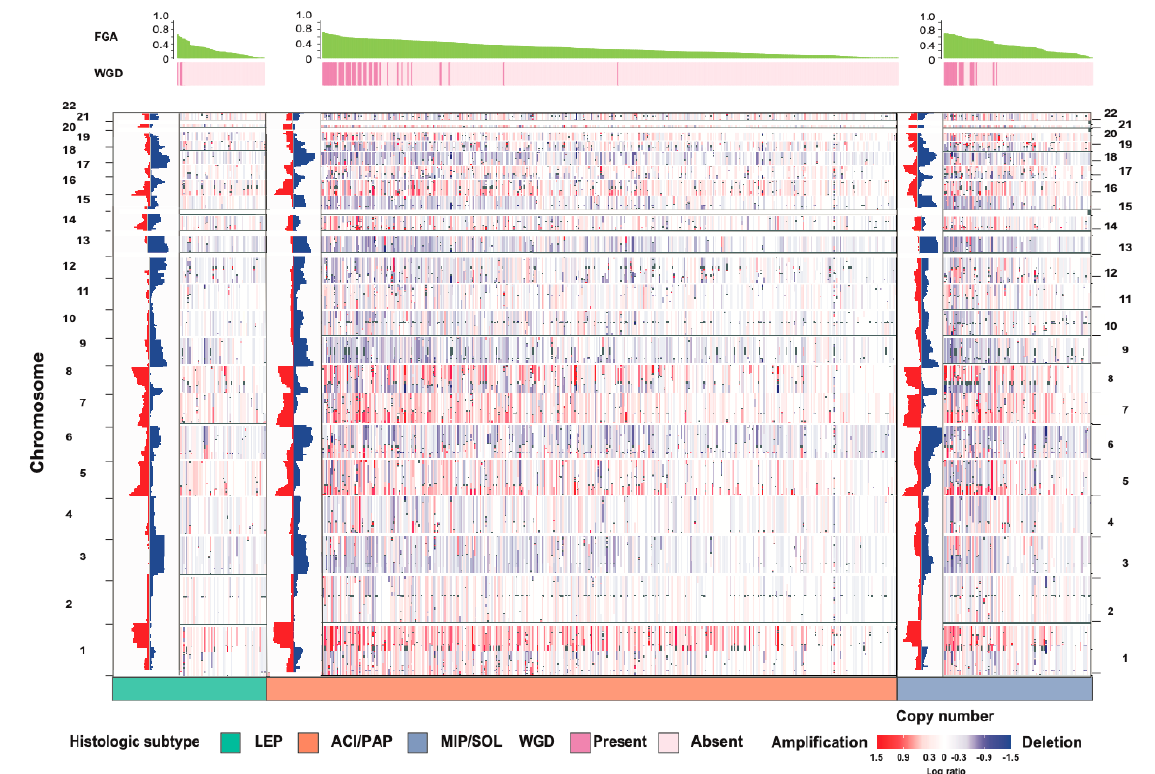
Figure 1. Analysis of copy number alterations by histologic subtype of invasive lung adenocarcinoma. The copy number heat map with amplifications (red) and deletions (blue) by histologic subtype, arranged by decreasing FGA. ACI, acinar; FGA, fraction of genome altered; LEP, lepidic; MIP, micropapillary; PAP, papillary; SOL, solid; WGD, whole-genome doubling. (From Journal of Thoracic Oncology , Caso, R.; Sanchez-Vega, F.; Tan, K.S.; Mastrogiacomo, B.; Zhou, J.; Jones, G.D.; Nguyen, B.; Schultz, N.; Connolly, J.G.; Brandt, W.S., “The underlying tumor genomics of predominant histologic subtypes in lung adenocarcinoma.” Vol. 15, 1844–1856. Copyright © (2020) Elsevier. Reprinted with permission).